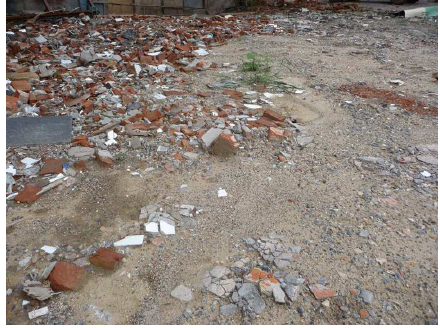
Fig. 10. The T distribution of optimal path of the experi- ment 1. e